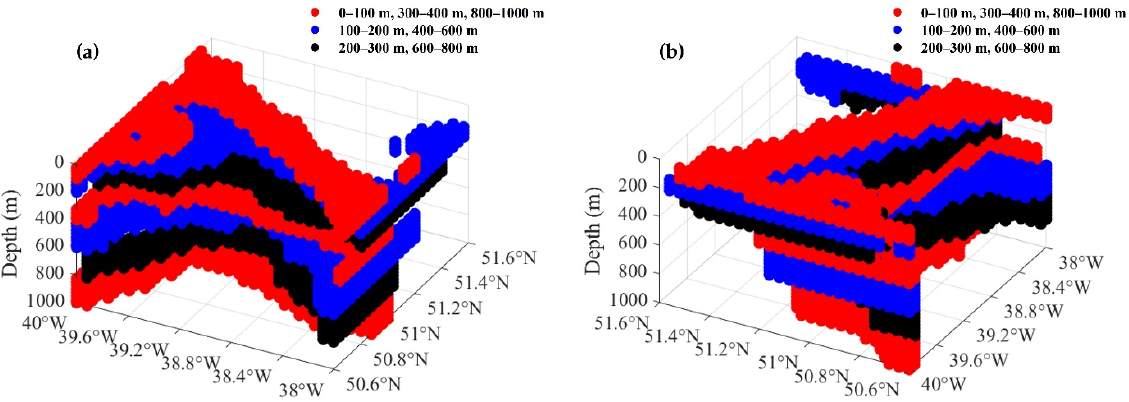
Figure 9. The three-dimensional geometric structure of the GSF obtained by iterative hierarchical clustering of sound speed profiles based on K-means algorithm: ( a ) angle 1; ( b ) angle 2. The influence depth of the GSF is 0–1000 m. Finally, it is divided into seven layers. Different color regions represent the results in different layers.